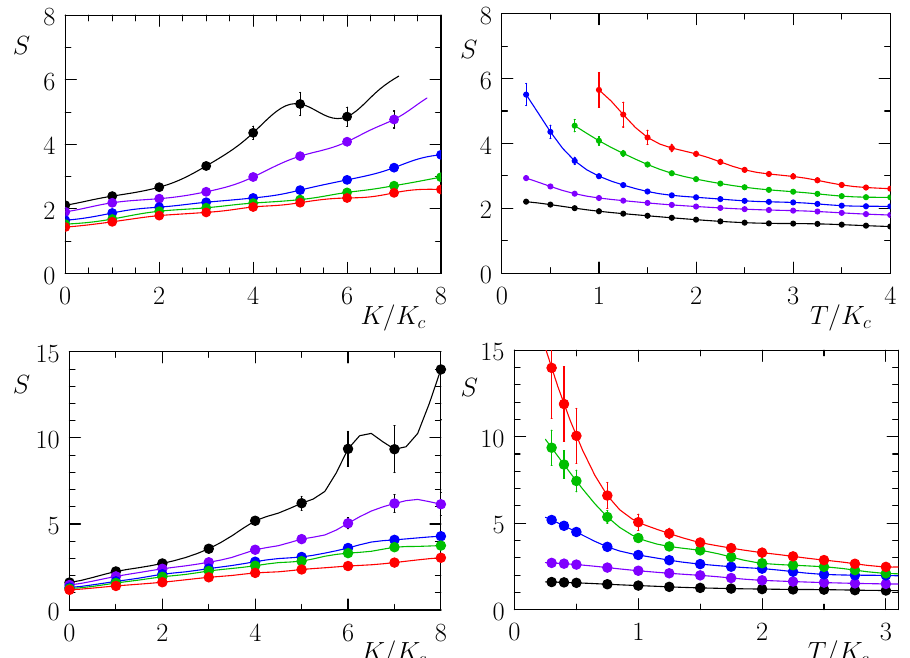
Figure 4. Dependence of the Seebeck coefficient S on the rescaled potential amplitude K / K c ( left column) and temperature T / K c ( right column) for N / L = 34/21 = ν 1.618 ( top row) and N / L = ≈ 55/21 = ν 2.618 ( bottom row). Left: color curves show the cases T / K c = 0.5,1,2,3,4 for N / L = ≈ 34/21 and T / K c = 0.3,0.8,1.3,1.6,2.3 for N / L = 55/21 (black, violet, blue, green, red from top to bottom curves). Right: K / K c = 0,2,4,6,8 for N / L = 34/21 and N / L = 55/21 (black, violet, blue, green, red from bottom to top curves). Here, K c = 0.019 for ν = 34/21 and K c = 0.14 for ν =